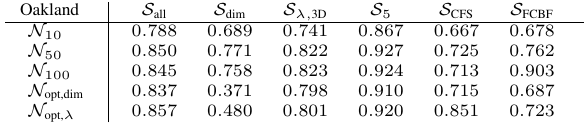
Table 6: Overall accuracy for QDA-based classification using dif- ferent neighborhood definitions and different feature sets.